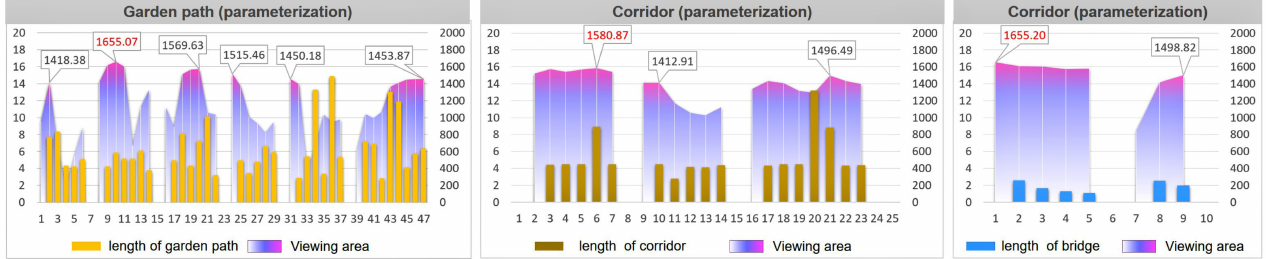
Figure 18. The comparison chart of the superposition of the length of one side of the road and the area of the viewshed generated by